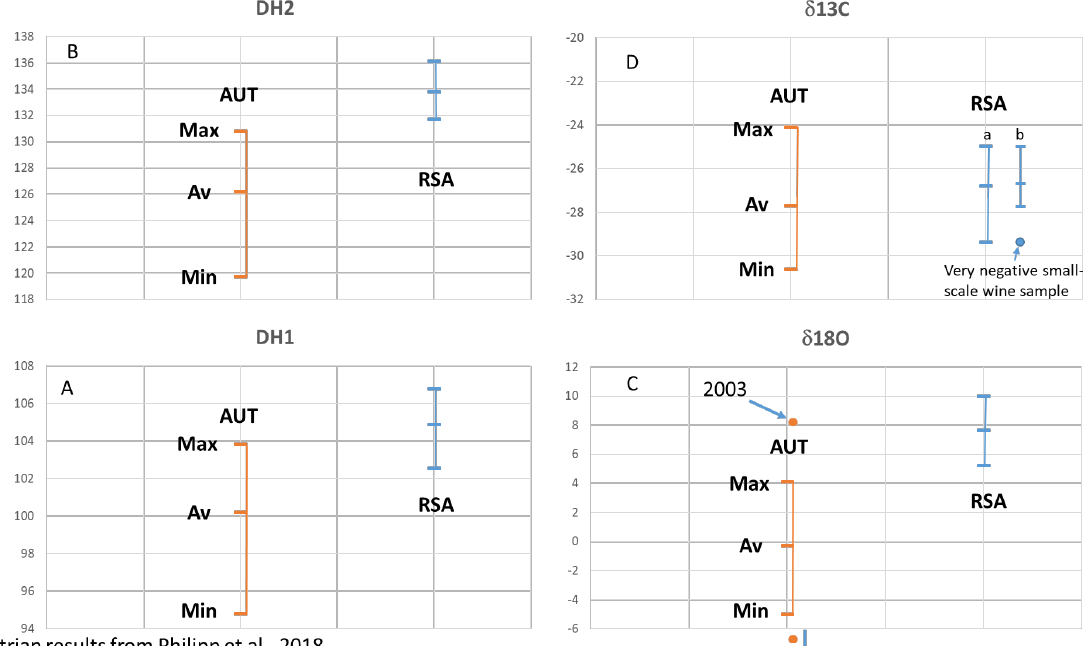
Figure 3. ( A – D ) South African (RSA) wine isotope results versus Austrian (AUT) wine isotope results for vintages 1997–2004. All values are reported in ‰ versus V-PDB for δ 13 C, in ‰ versus V-SMOW for δ 18 O, and in ppm for (D/H)I and (D/H)II. Austrian results from Philipp et al., 2018 [9]. ( C ): “2003” marks the Austrian sample from vintage 2003 with a very high δ 18 O-value. An Austrian sample with a very low δ 18 O value below −6‰ is a “dry-berry”-sample. ( D ): South African results are presented as bar (a) including all samples, and bar (b) showing separately the depleted values of small-scale samples of Sauvignon Blanc from winery S.